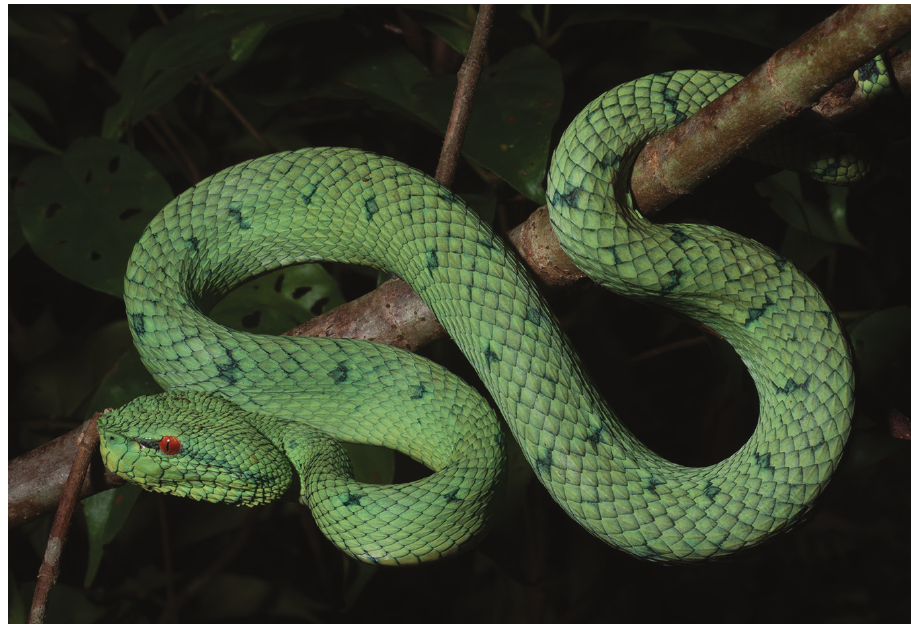
Figure 80. Tropidolaemus philippensis (KU 334490) from Mt. Lumot, Municipality of Gingoog City, Misamis Oriental Province. Photo: